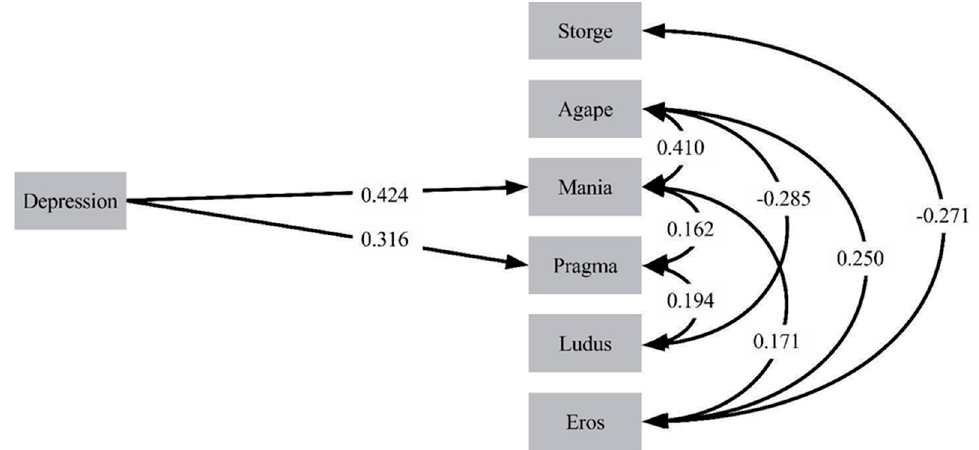
Figure 2. Final path analytic model of the effects of depression on attachment romantic styles in females.